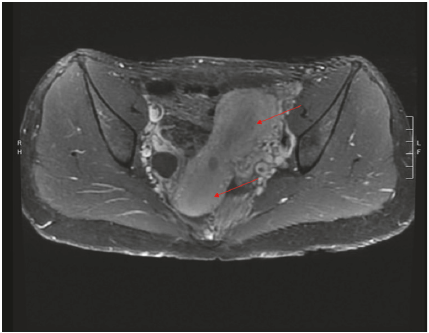
Figure 3: MRI demonstrating bicornuate